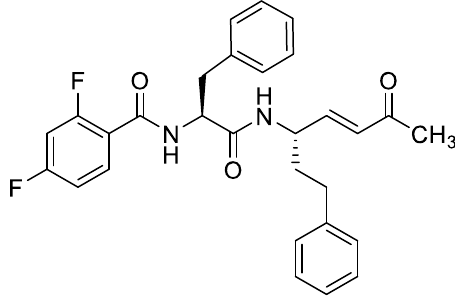
Figure 6. Chemical structure of a new lead for HAT drug discovery.